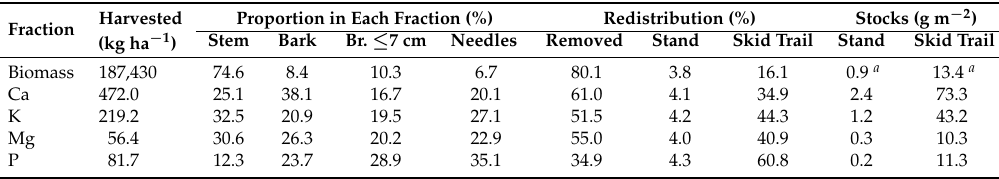
Table 2. Harvested biomass and nutrient stocks at the stand scale (modeled, kg ha − 1 ); their respective redistribution either through removal, left in stand, or deposition on skid trails; and resulting additional meso-scale stocks in stand and skid trail not including pre-harvest stocks (4.5 m skid trail per 20 m of forest; g m − 2 · 10 = kg ha − 1